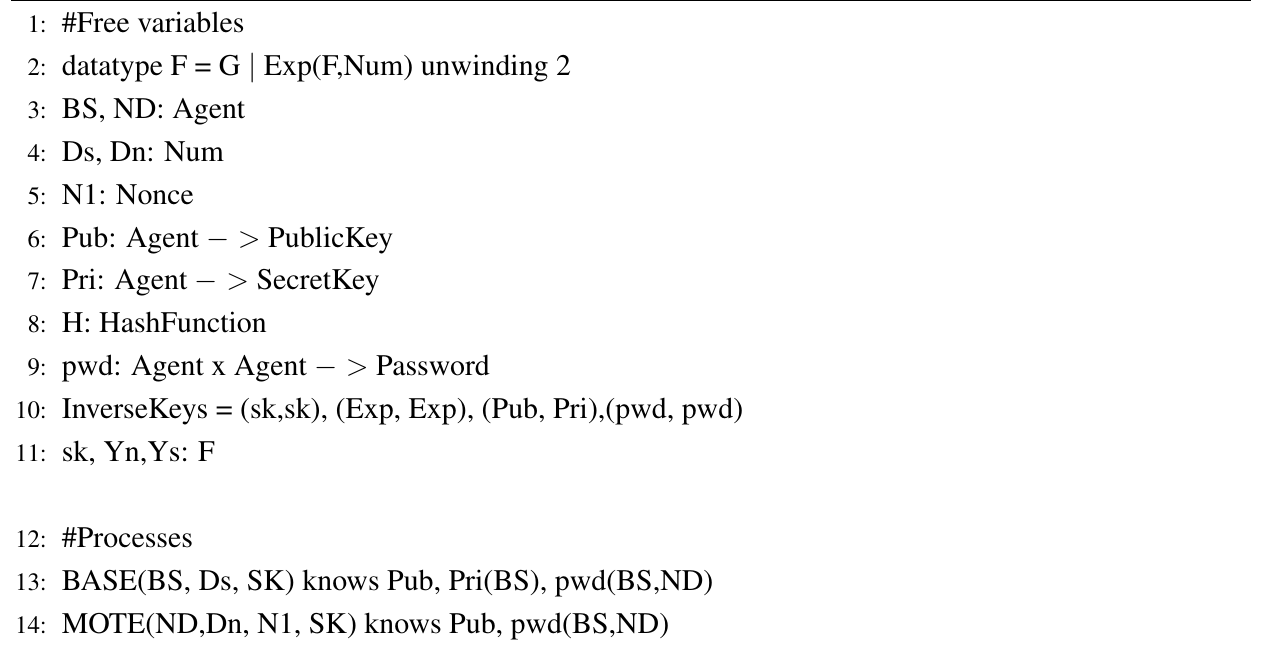
Algorithm 4 Seluge++ key generation implemented in